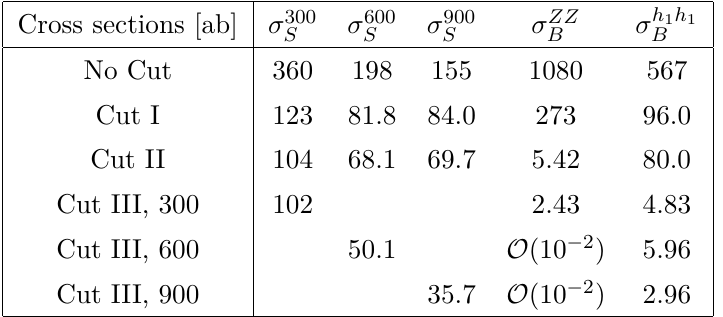
= 300, 600, 900 GeV and 2